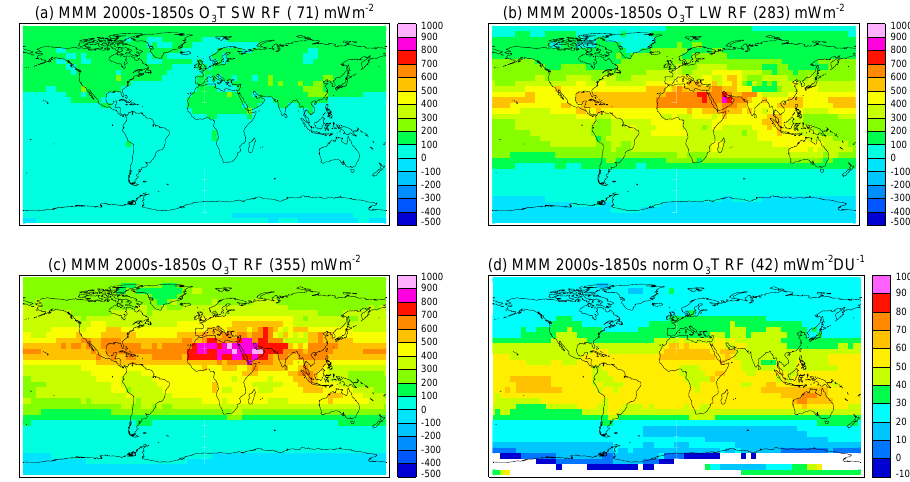
Fig. 3. Multi-model mean, annual mean tropospheric ozone radiative forcings (mW m − 2 ) , for: (a) SW; (b) LW; (c) total (SW + LW); and (d) total RF normalised by tropospheric column ozone change (Fig. 1f) (mW m − 2 DU − 1 ) . The normalised RF is masked (white boxes) where the change in ozone column is less than 0.25DU. Area-weighted global mean values are given in brackets. Figure S2 shows equivalent plots for all individual